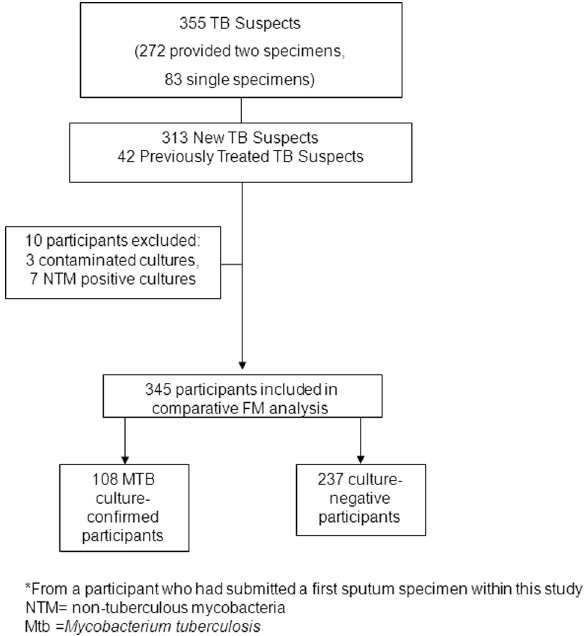
Figure 1. Diagram of study flow. NTM = non-tuberculous mycobacteria, Mtb = Mycobacterium tuberculosis .